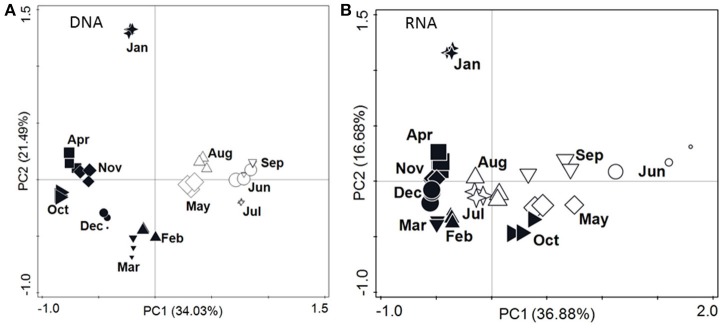
Principal component plots of the relative abundance of OTUs inferred from the sequencing of 16S rRNA gene fragments at DNA level (A) and RNA level (B). The size of the symbols indicates the Shannon-Wiener index of the sample; the smallest symbols indicate an index of 3.65 and 2.99, while the largest symbols indicate an index of 4.30 and 4.67 for DNA level and RNA level, respectively. Closed symbols represent samples obtained when the soil was frozen (November through April). Note: Data points denoted “Apr” represent the soil core collected May 3rd 2010.